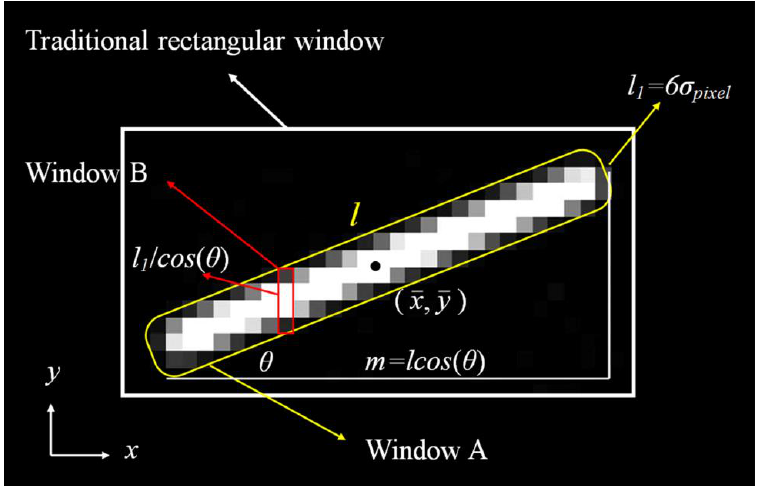
Figure 5. Detailed description of centroiding